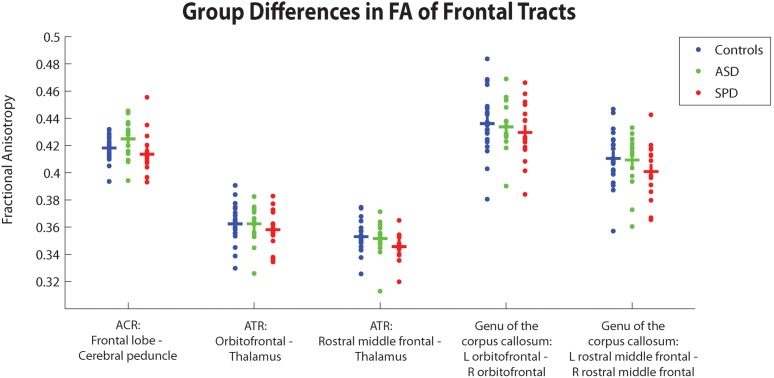
Group differences between TDC, SPD, and ASD subjects in average FA within different frontal tracts.Crossbars correspond to group averages. Green asterisks depict significant group differences between ASD and TDC subjects, and red asterisks depict significant group differences between SPD and TDC subjects, FDR corrected at p<0.05.